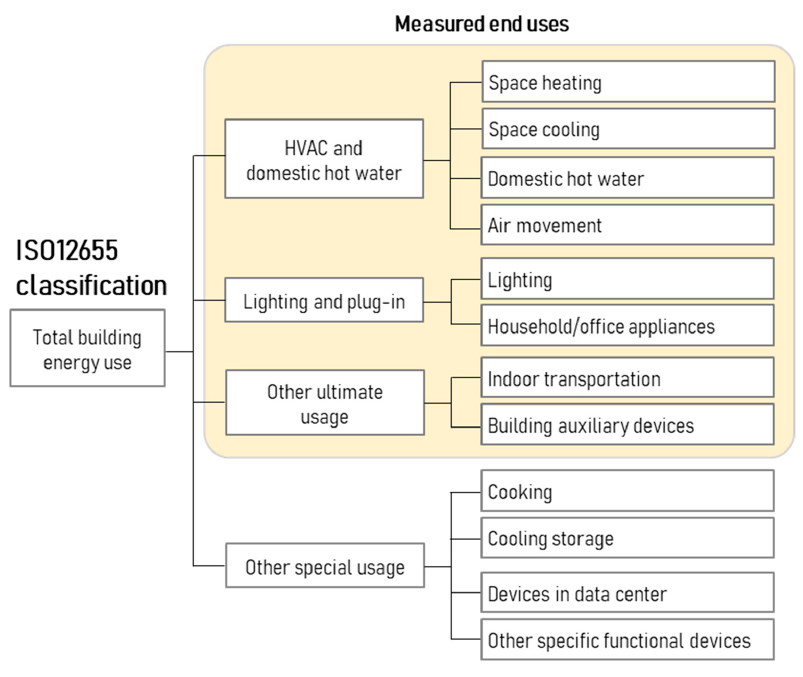
Figure 2. Measured end-uses.